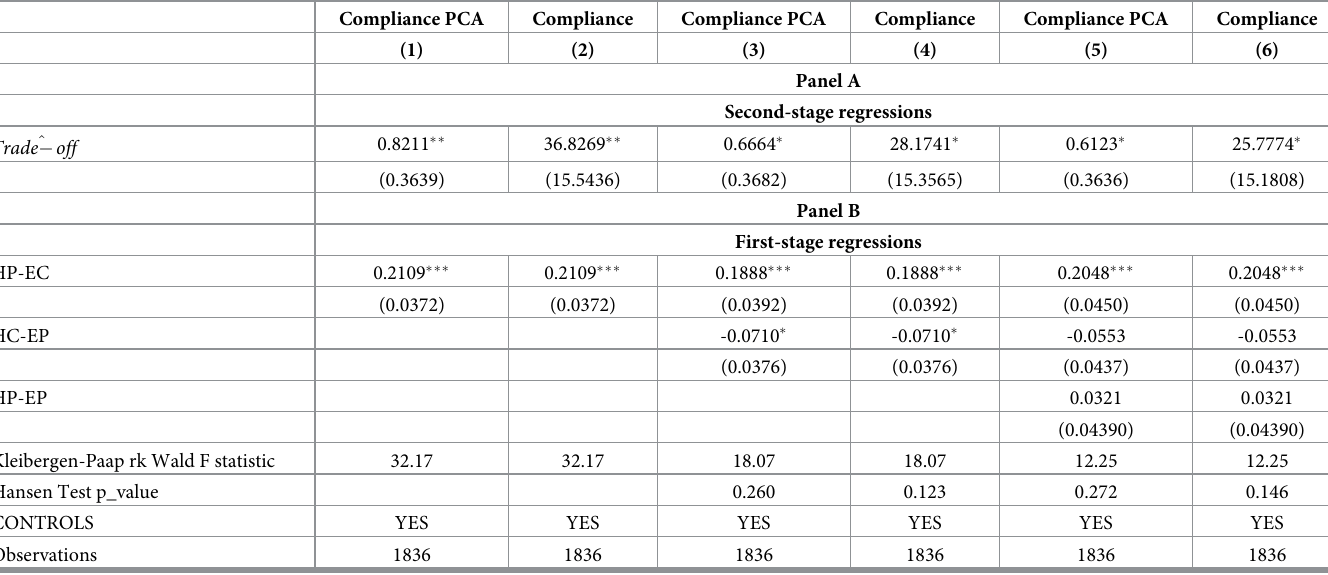
Table 6. Intention to adhere to prescribed behaviors and health-economy